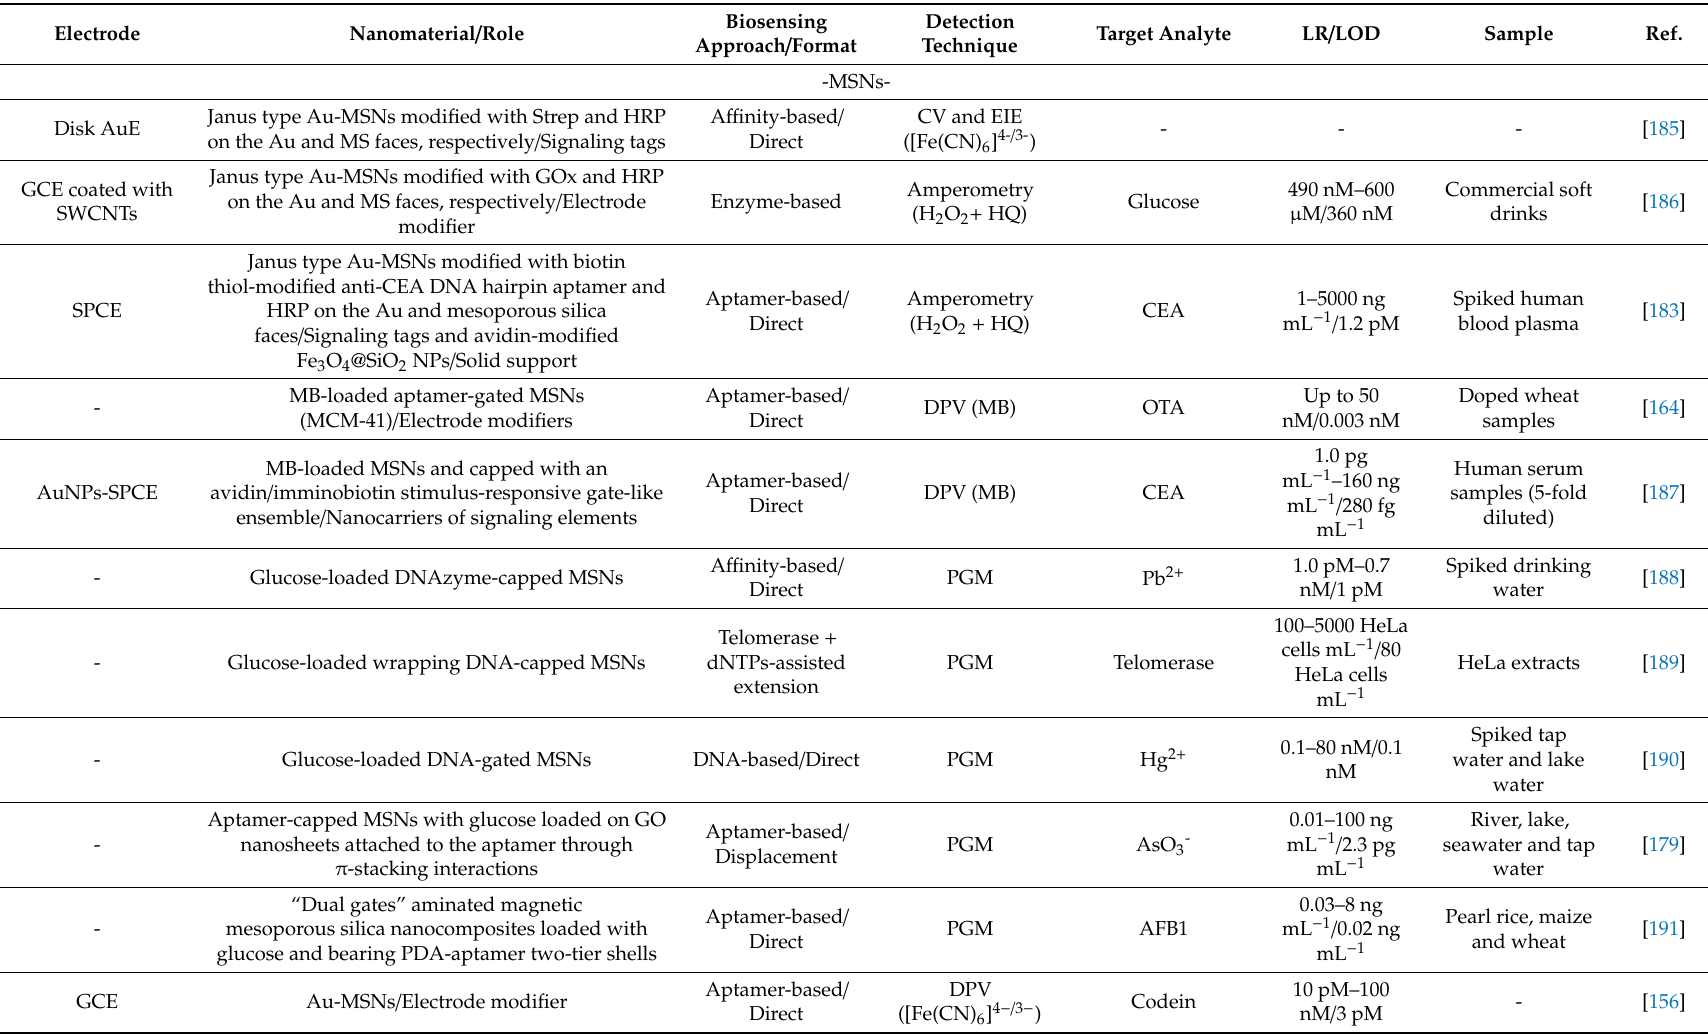
Table 4. Electrochemical biosensors and biosensing methods involving multifunctional silica nanomaterials.